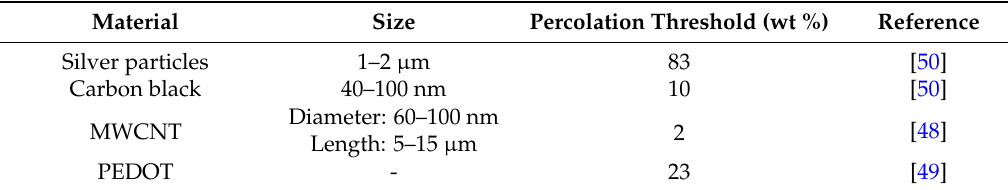
Table 2. Conductive fillers for stretchable conductors based on